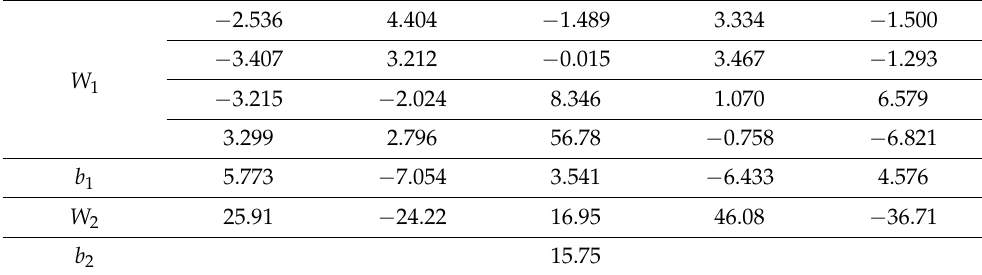
Table 2. Trained neural network parameters.